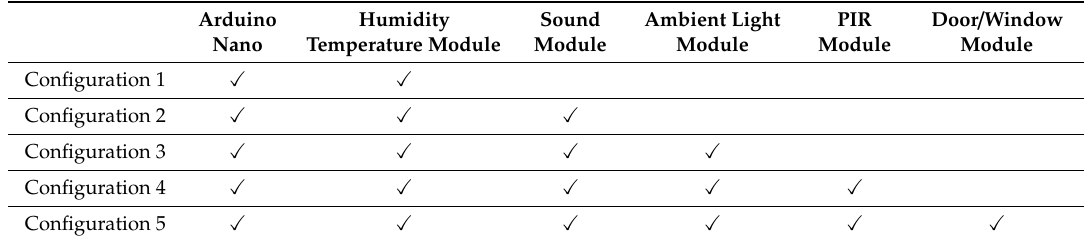
Table 3. Different WSN node configuration used in the experiments. Table 3. Di ff erent WSN node configuration used in the